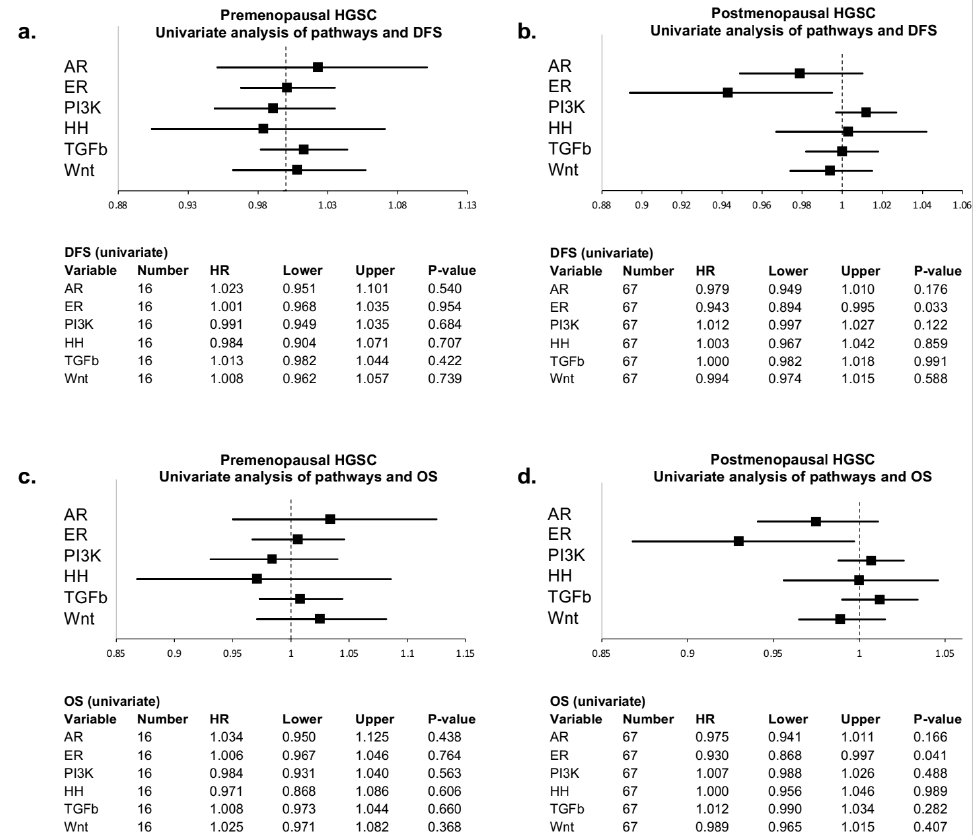
Figure 2. Forest plots of univariate Cox proportional hazards regression analysis of all pathways and survival. Hazard ratios (HR) with 95% confidence intervals are described for disease-free survival (DFS) in ( a ) premenopausal and ( b ) postmenopausal women, and overall survival (OS) in ( c ) premenopausal and ( d ) postmenopausal women.